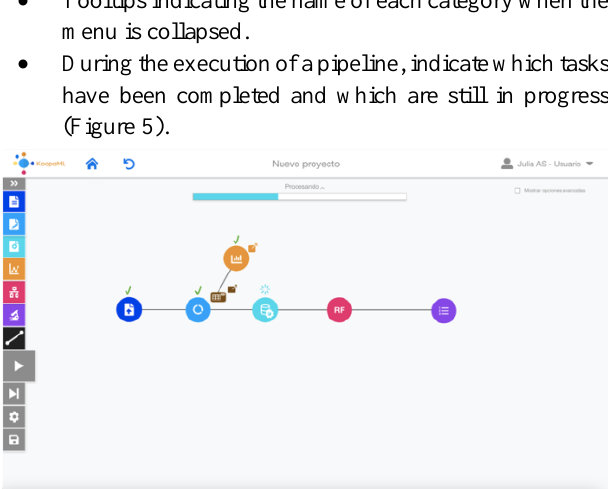
Figure 5. Second digital prototype of the execution of the pipeline.